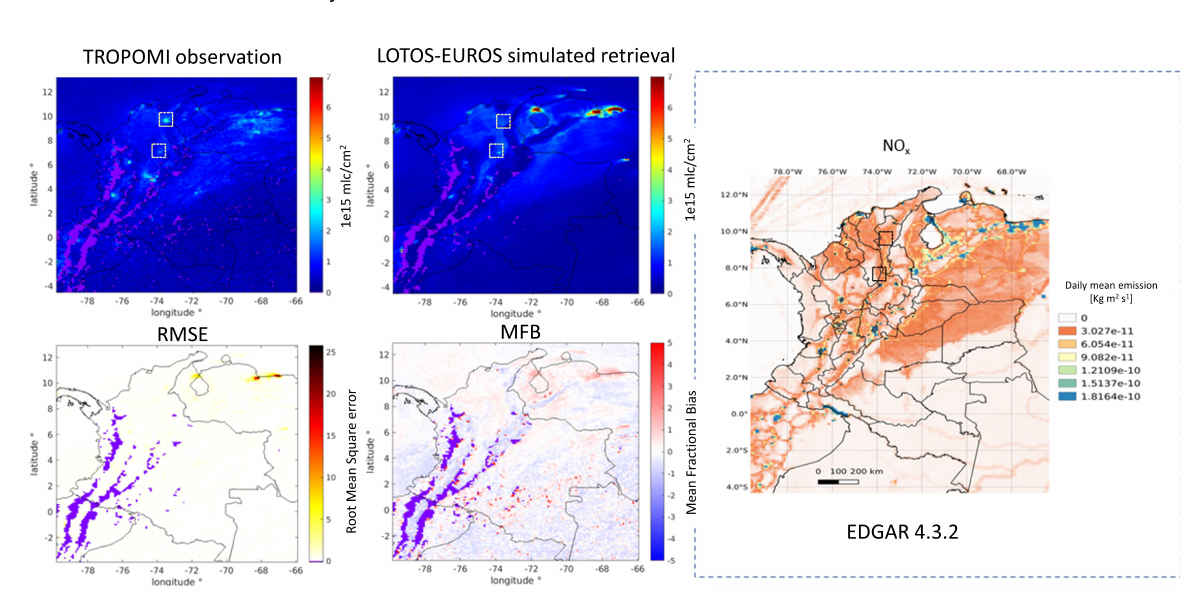
Figure 5. ( Top left and centre ) Fifteen days mean (16 January–1 February 2019) of the TROPOMI tropospheric NO 2 vertical column and the corresponding LOTOS-EUROS simulations. Purple areas correspond to areas where no data was available, mainly due to the cloudiness presence over the area for all that time. The dashed yellow squares correspond to two locations selected to update emissions that are not principal cities but considerable concentration spots seeing from the remote sensing instrument to qualitatively detect the right place to estimate unknown or uncertain parameters. ( Bottom left and centre ), root mean square error and modified-fractional-bias between retrieval and simulation. ( Right ), EDGAR V4.3.2 anthropogenic NO x emissions,